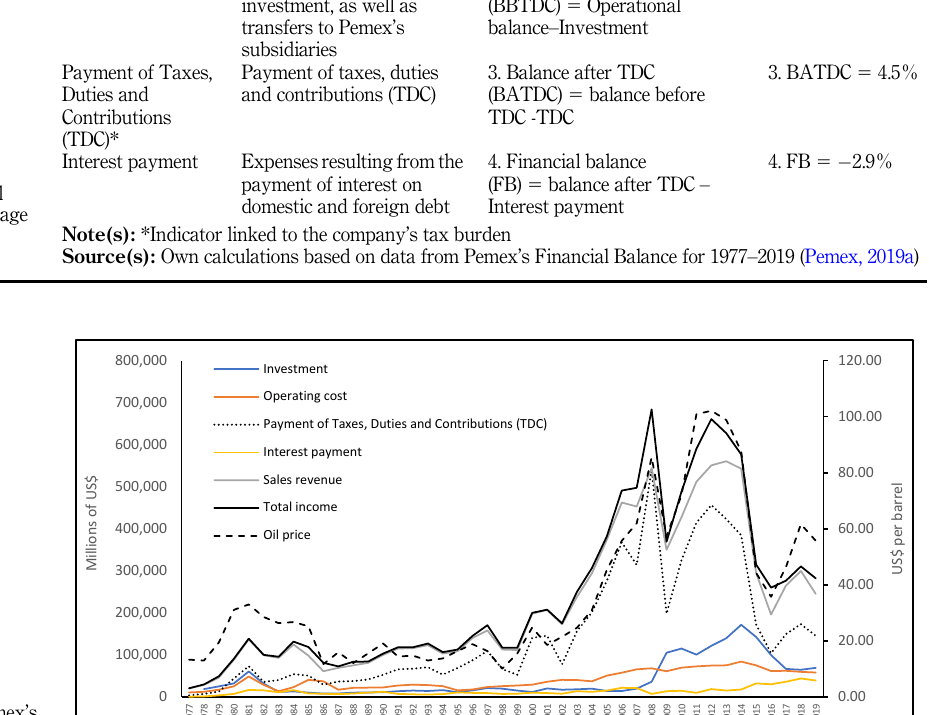
Figure 3. Oil price and Pemex ’